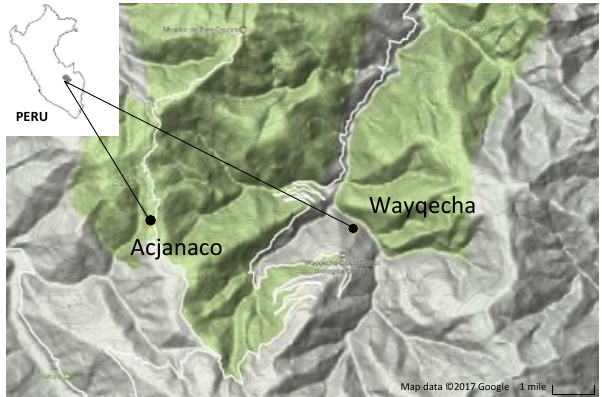
Figure 1. Map illustrating the two sites in the high-elevation mon- tane grassland (circles). The green area represents the Manu Na- tional